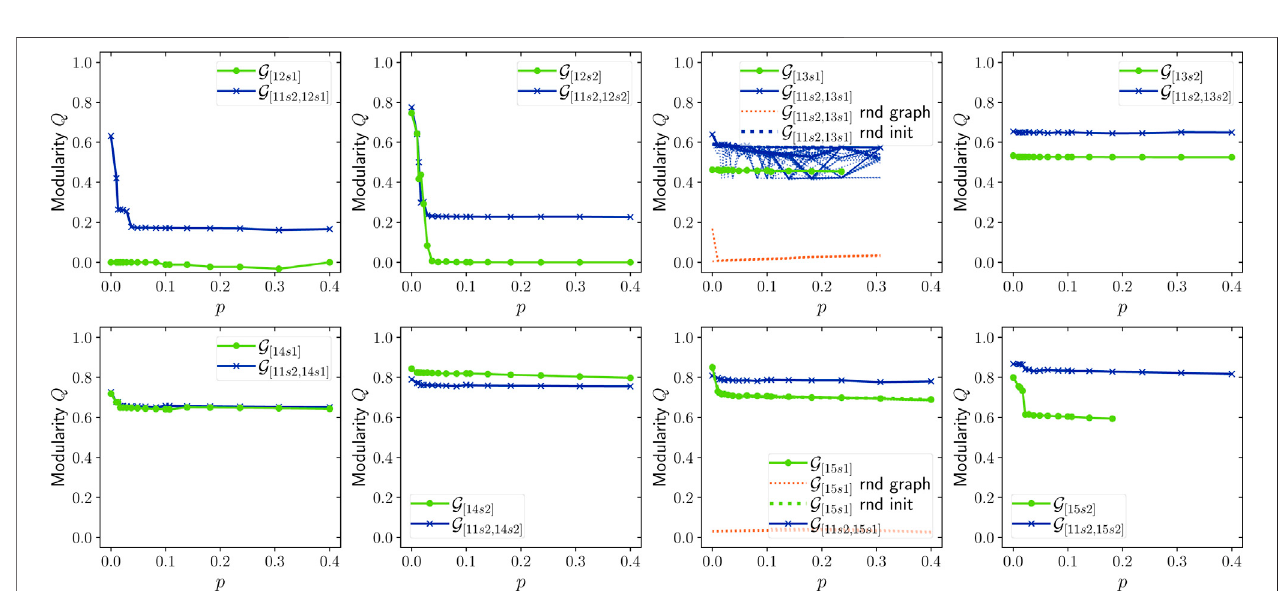
FIGURE 12 | Modularity as a function of p